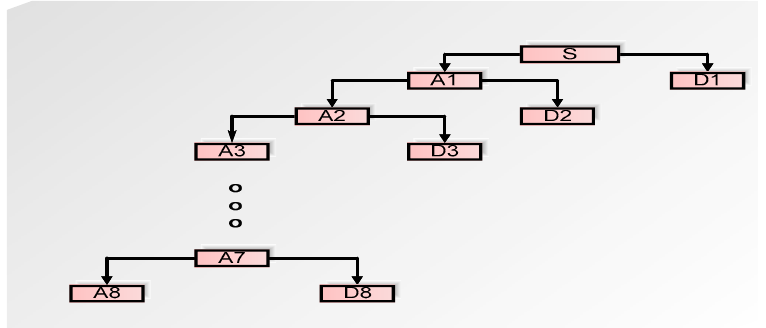
Figure 3. Discrete Wavelet Transform (DWT) Decomposition at eight levels.